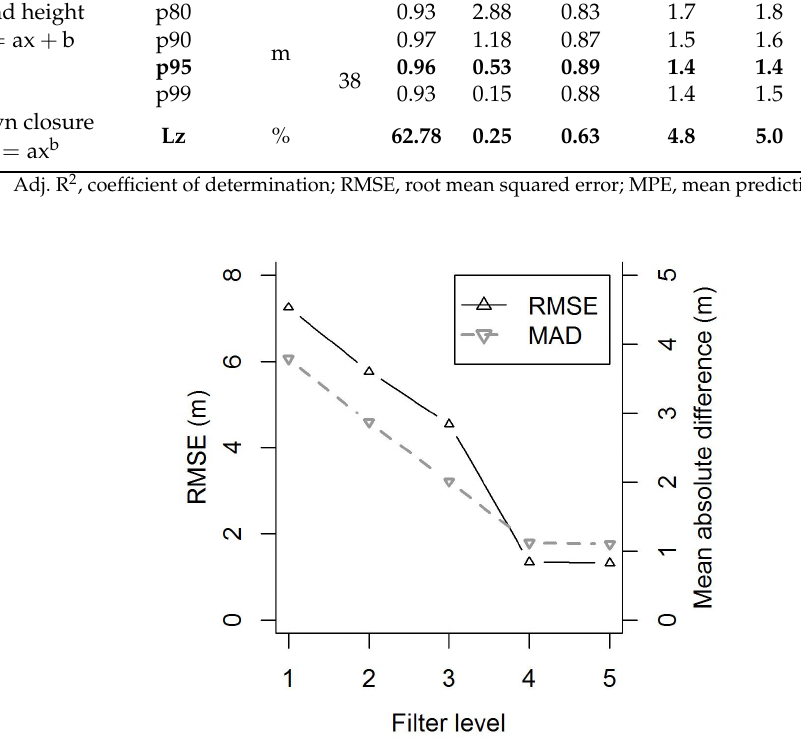
Figure 3. Summary of the change of root mean squared error (RMSE) and mean absolute difference (MAD) noted between intersecting Geoscience Laser Altimeter System (GLAS) and transect LiDAR estimates of stand height as a function of five different levels of quality